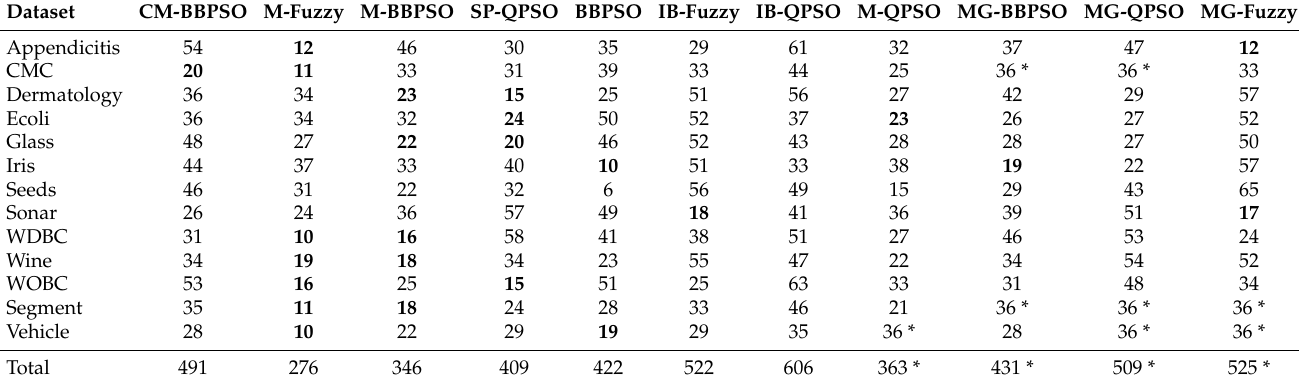
Table 7. Sum rank values of algorithms for all 6 metrics for each dataset with best two algorithms presented in bold. Dataset